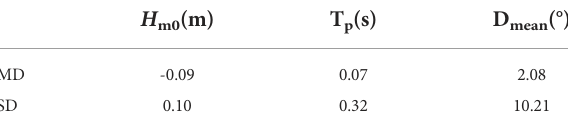
TABLE 5 Statistics of mean deviation(MD) and standard deviation (SD).